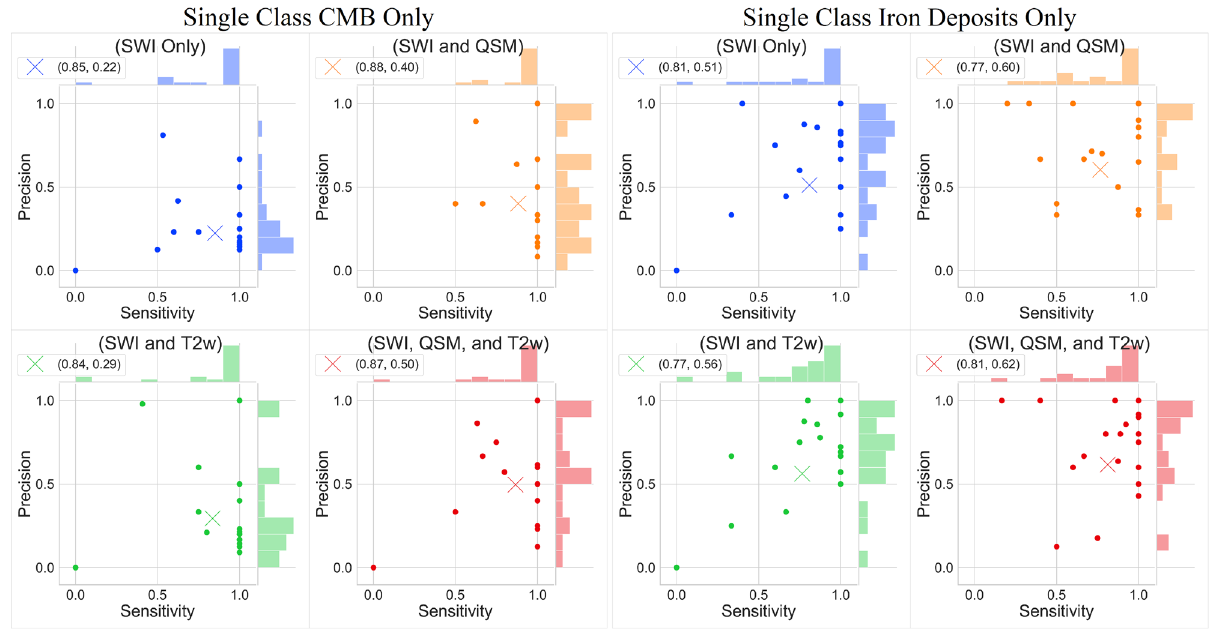
Figure 2. Joint scatterplots of the sensitivity vs precision of all single class experiments predicting CMBs and non-hemorrhage iron deposits. (Left) all CMB only experiments and (Right) all iron deposits only experiments. In each subplot, the round points indicate the individual participants’ sensitivity and precision evaluated with leave-one-out cross-validation, and the X indicates the mean sensitivity and precision. The legend at the upper left corner of each subplot shows the coordinates of X. In each subplot, histograms of the sensitivity and precision are displayed along the upper and right axes.